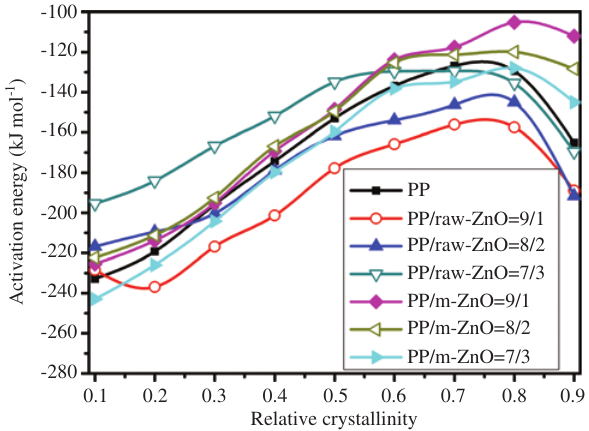
Figure 6 Curve of activation energy versus relative degree of crys- tallization of the PP/ZnO